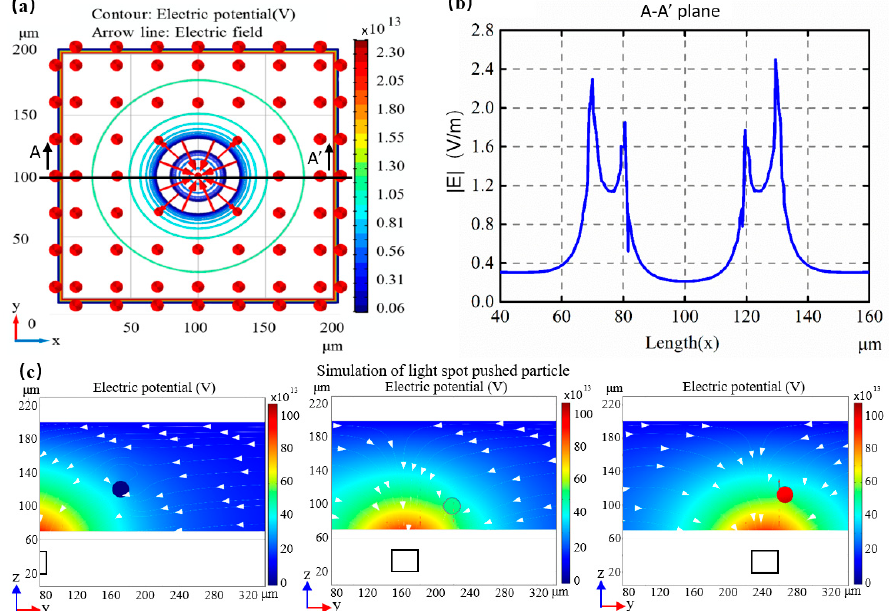
Figure 2. The distribution of electric field in the OET. ( a ) The electric potential and the directional distribution of the electric field; ( b ) The strength of electric fields in different lengths. A peak value appears near the junction of brightness and darkness, and then two peaks appear in the trapped ring; ( c ) Simulation of particles being pushed by light spot.